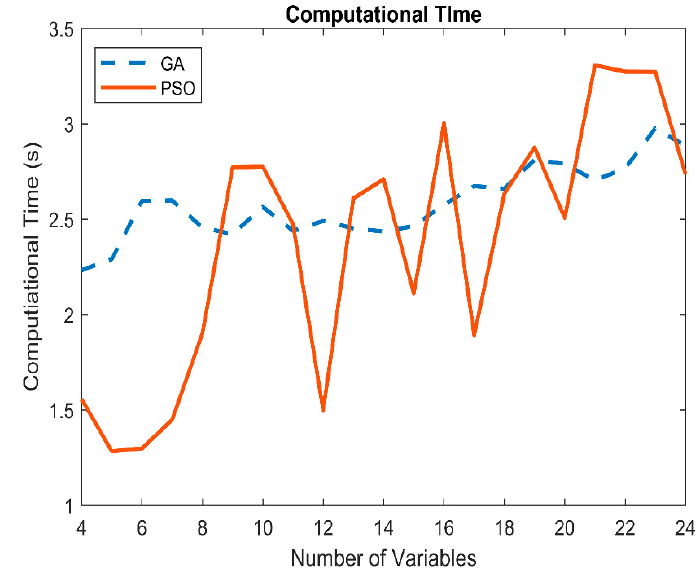
Figure 15. Computational time comparison between the PSO and the GA increasing the number of generations to 200.